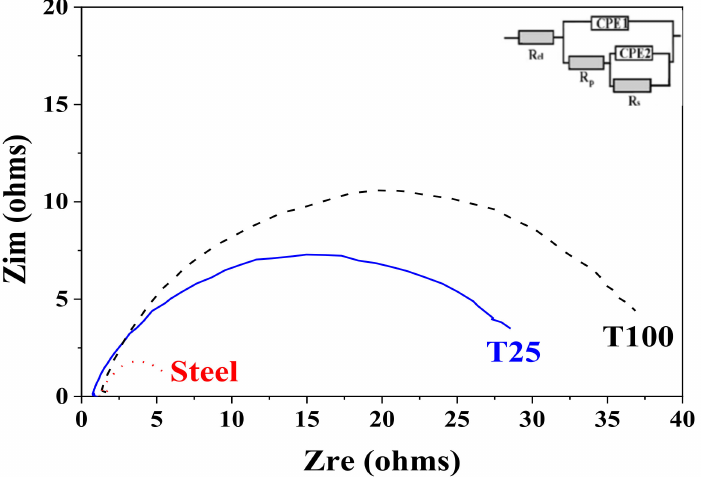
Figure 8. EIS studies of T25, T100 and low-carbon steel samples in model medium of 5 wt.% NaCl solution.